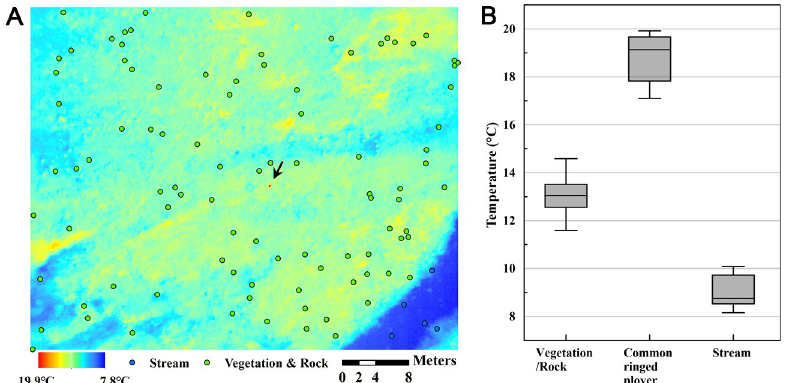
stream (blue circles) and vegetation and rock (green circles). (B) Temperature distribution of one common ringed plover body shape and randomly selected dots in each group.